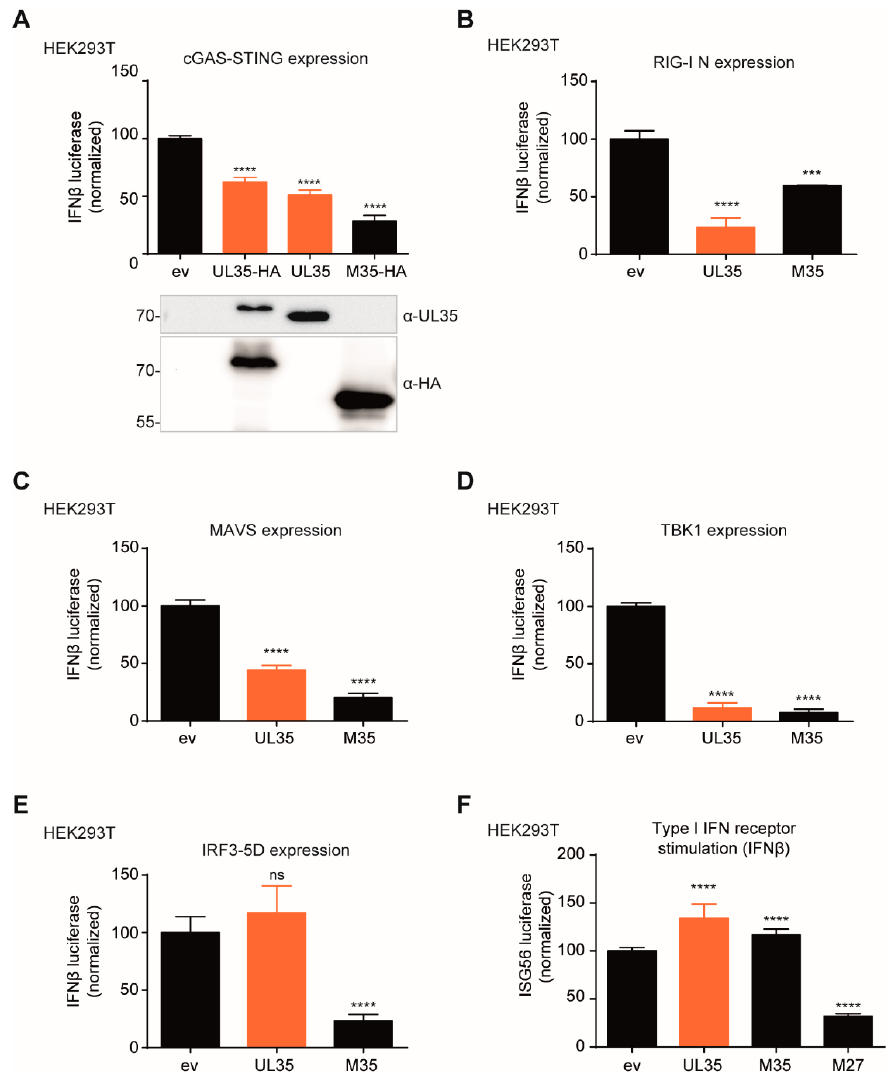
Figure 1. UL35 downmodulates transcription of IFN β in luciferase reporter assays. ( A ) HEK293T cells were co-transfected with a reporter plasmid coding for firefly luciferase under the control of the murine IFN β promoter (IFN β -Luc) together with a Renilla luciferase normalization control (pRL-TK) and expression plasmids for IRES-GFP (unstimulated) or cGAS-GFP (stimulated), Cherry-STING and either empty vector (ev), HA-tagged M35, HA-tagged UL35 or untagged UL35. Cells were lysed 20 h later and luciferase activity was analyzed. An anti-HA antibody was used for detection of HA-tagged versions of UL35 and M35, and expression of untagged UL35 was verified with a UL35-specific antibody. ( B – E ) HEK293T cells were transfected with expression plasmids for IFN β -Luc, pRL-TK and ( B ) RIG-I N, ( C ) MAVS, ( D ) TBK1, ( E ) IRF3-5D, or the respective ev. Cells were further co-transfected with either